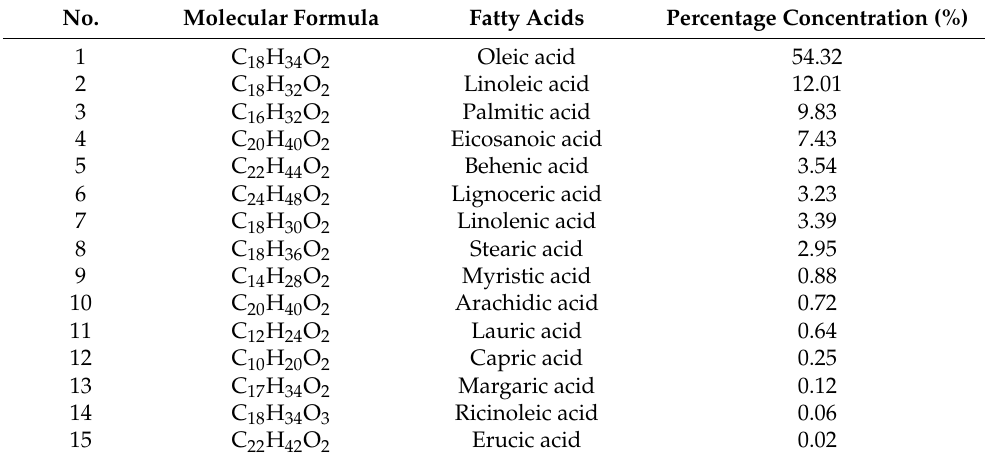
Table 1. Fatty acid profile of